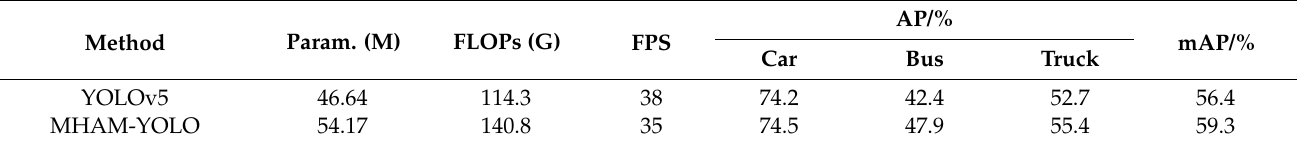
Table 4. Comparison of BDD100K